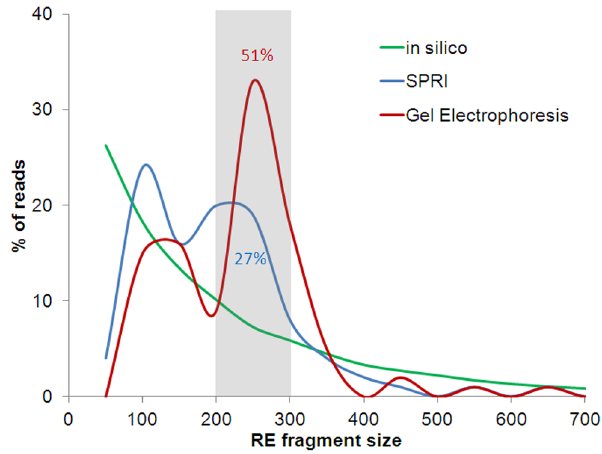
Figure 1. Distribution of RESCAN reads generated from two size selection methods. In silico NlaIII digestion of total Nipponbare genome (black line) showed that about 13% of total restriction fragments exist in the range of target size (200–300 bp). About 51% of the reads from the gel electrophoresis (LabChip) method were in the target range compared to 27% of the reads from the SPRI (AMPure) method.